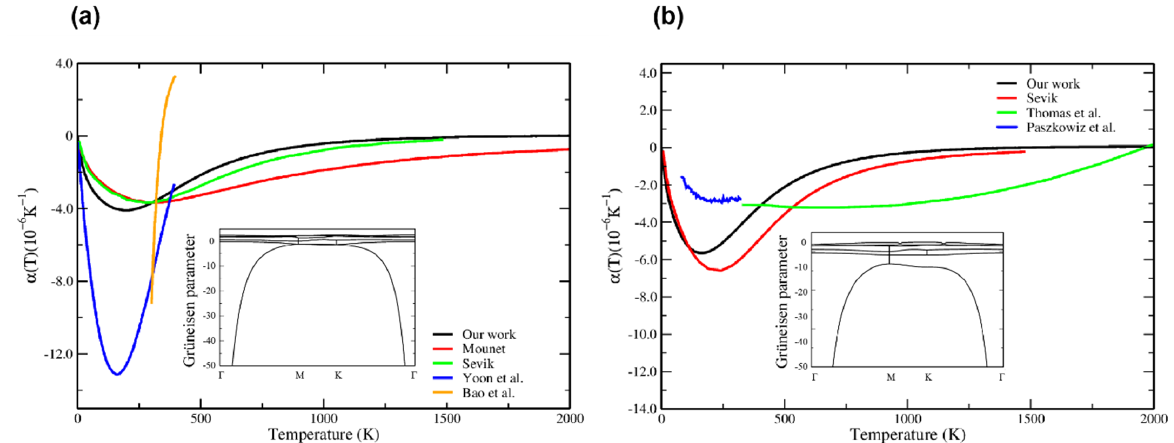
Figure 6. LTECs of ( a ) graphene, where the black color curve denotes our work, and other colors are for References [18,37,41,42], and ( b ) h-BN where the black color curve denotes our work, and other colors are for References [60,61]. The insets are the mode-dependent Grüneisen parameters for the parent systems.